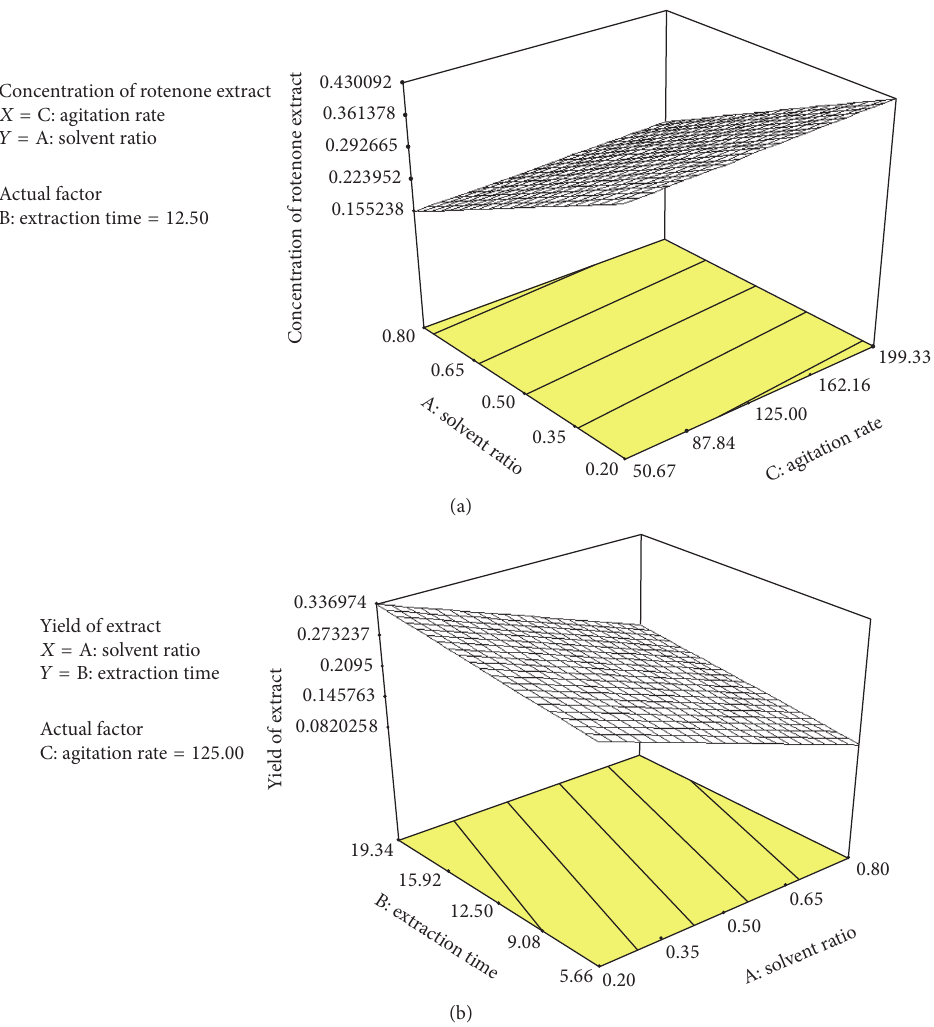
Figure 6: Response surface plot corresponding to rotenone concentration (a) as a function of solvent ratio and agitation rate and rotenone yield (b) as a function of extraction time and solvent ratio.